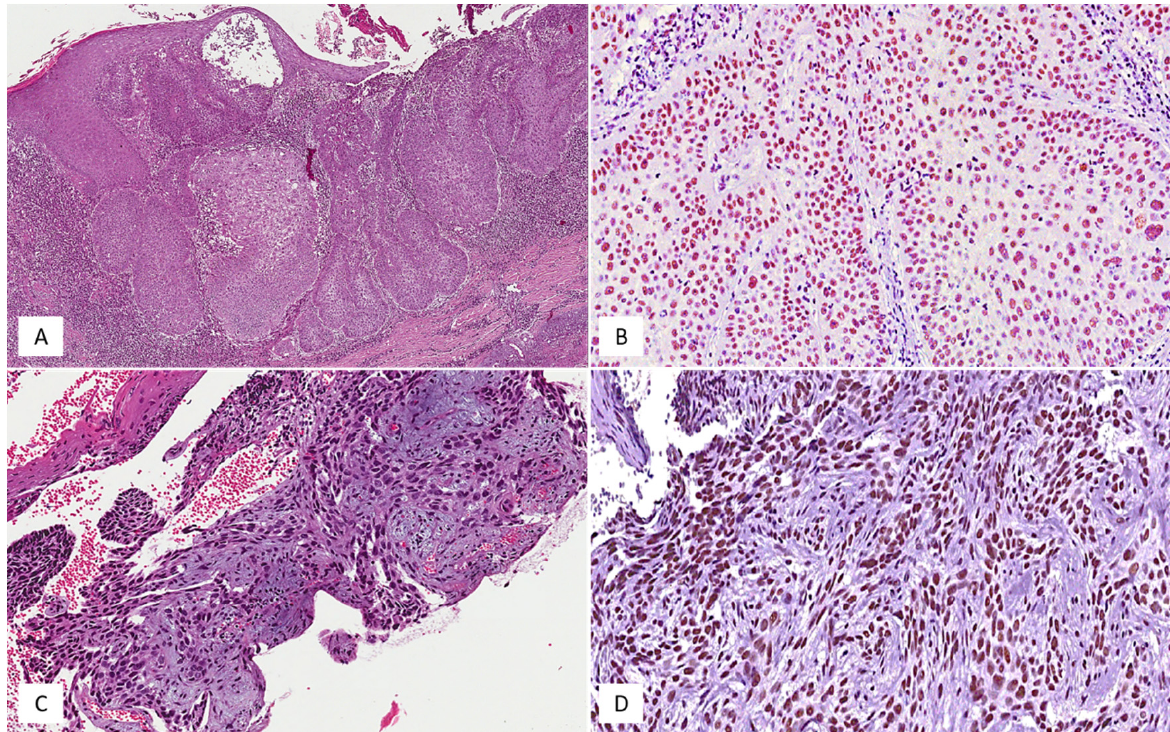
Figure 2. High-risk subtype of basal cell carcinoma. ( A ) Histological examination of basosquamous carcinoma showing nests and islands of basaloid cells with squamous differentiation; hematoxylin and eosin, original magnification 50 × . ( B ) Neoplastic cells of basosquamous carcinoma are diffusely and strongly stained with SRSF1; hematoxylin and eosin, original magnification 200 × . ( C ) Histological detail of a case of sclerosing/morphoeic basal cell carcinoma, exhibiting strands and confluent nests of basaloid cells, set in a dense fibrous stroma; hematoxylin and eosin, original magnification 200 × . ( D ) The same case of sclerosing/morphoeic basal cell carcinoma is strongly and diffusely stained with SRSF1; hematoxylin and eosin, original magnification 250 ×